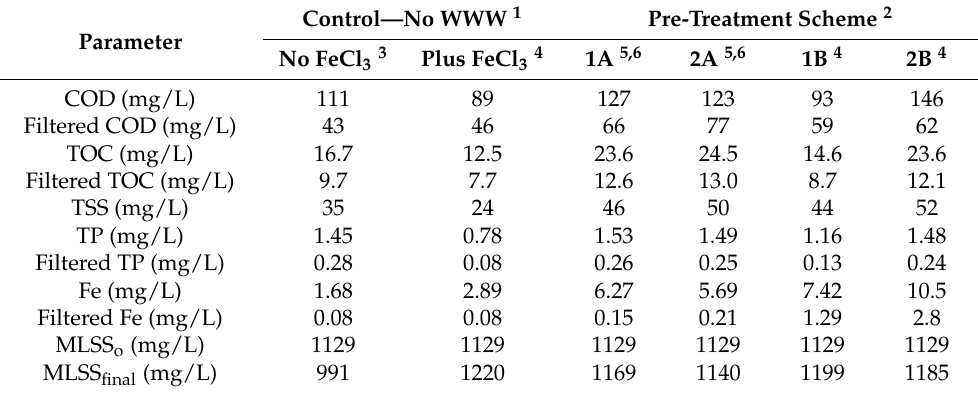
Table 6. Simulated secondary effluent concentrations and mixed liquor characteristics after 3 h of aerobic oxidation using mixed liquor from a municipal WWTP treating WWW after undergoing various types of